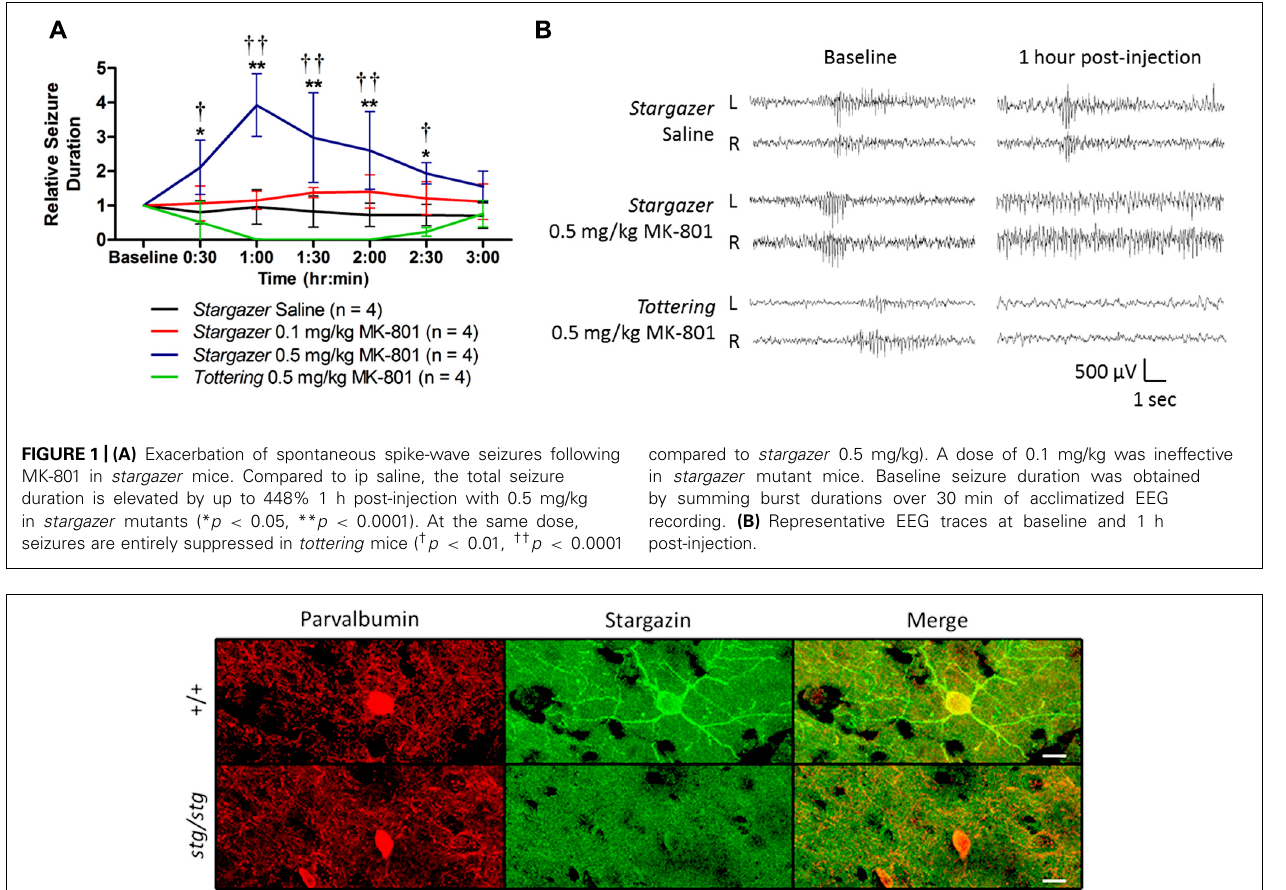
FIGURE 2 | Stargazin expression is restricted to PV + interneurons inWT mouse somatosensory cortex (upper row). Somatodendritic stargazin immunoreactivity is lost in PV + interneurons in stargazer mouse (lower row). Co-labeling of stargazin and parvalbumin antibodies shown in layer 2/3 at 63 × magnification (scale = 10 μ